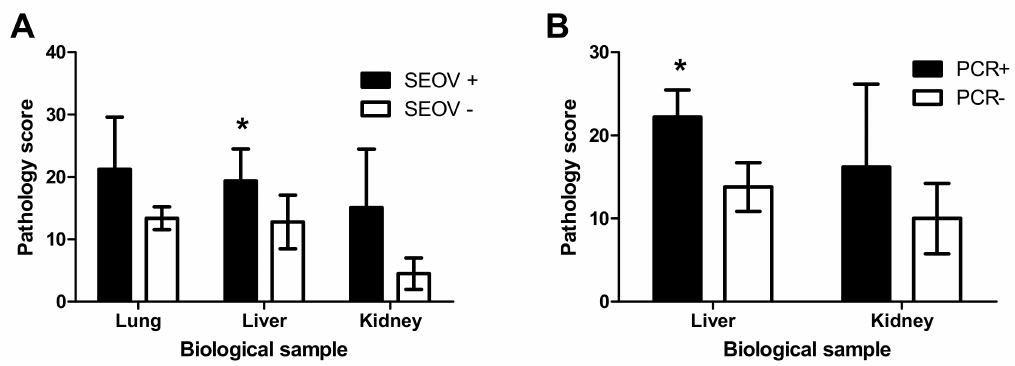
Figure 2. Pathology scoring in lung liver and kidney of SEOV infected rats. A comparison of histological scoring of samples stained with haematoxylin & eosin (HE) was performed between adult animals that were seropositive (SEOV + ) and juvenile animals that were seronegative (SEOV − ; ( A )), or in adult animals that were positive (PCR + ) or negative (PCR − ; ( B )) for viral RNA in liver or kidney. Bars present the average score between animals. The error bars represent the standard deviation of the mean (* = p < 0.05, Student’s t -test).